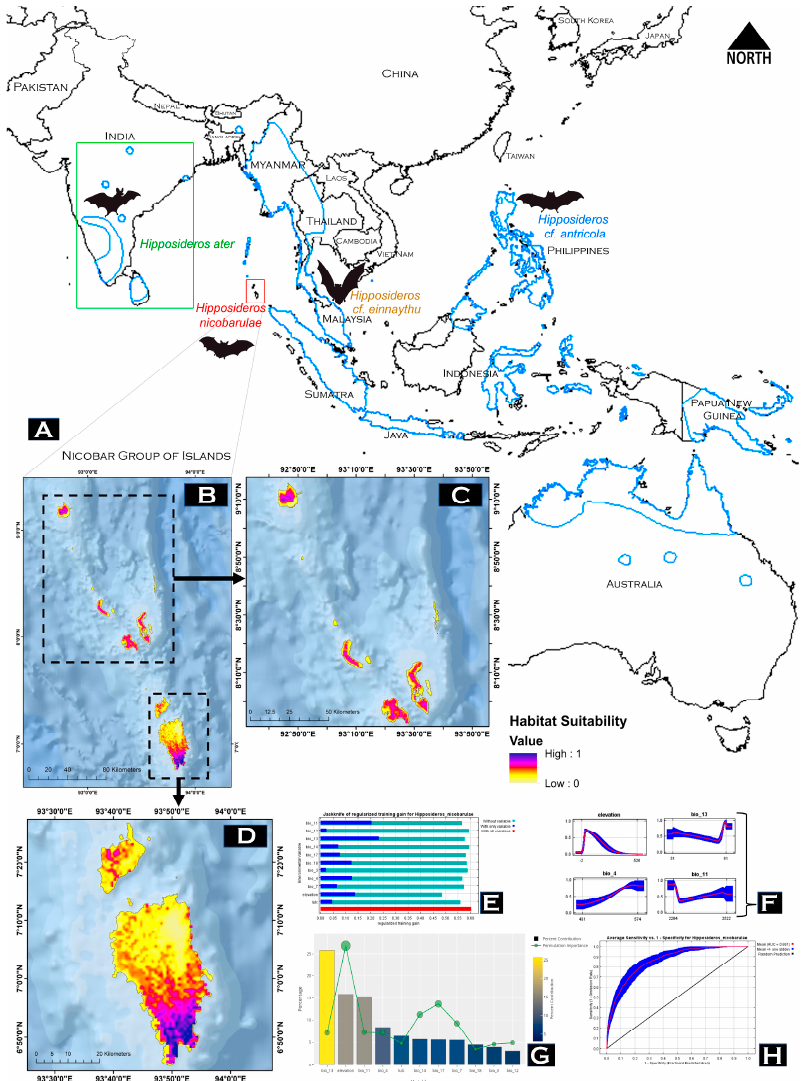
Figure 4. ( A ) The distribution pattern of H. nicobarulae and other closely related species ( H. cf. einnaythu , and H. cf. antricola ), elevated as a distinct species from H. ater , ( B ) Representing the probability of suitable habitats of H. nicobarulae in its extent distribution range, ( C ) Representing the distribution probability in the northern range within Car Nicobar, Terresa, Kamorta, Katchal and Nancowry Islands, ( D ) Representing the distribution probability in the southern range within Little Nicobar and Great Nicobar. ( E ) Jackknife test for all the eleven variables ( F ) Response curves of the important variables for habitat suitability of H. nicobarulae , ( G ) Percentage contribution is represented by a column graph (color ramp = percentage contribution), and permutation importance is represented by the circular plot (size = permutation importance). ( H ) The average training ROC for the final model